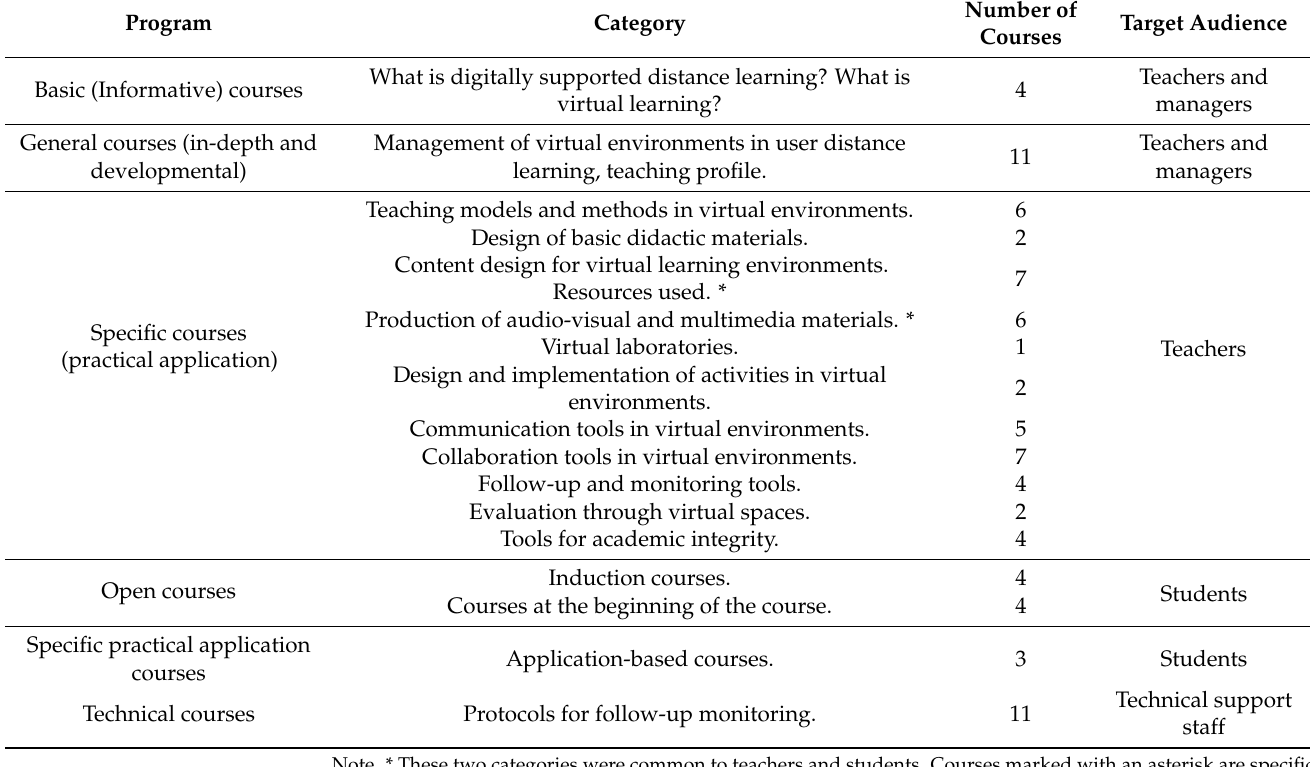
Table 4. Categorization of training plan courses.